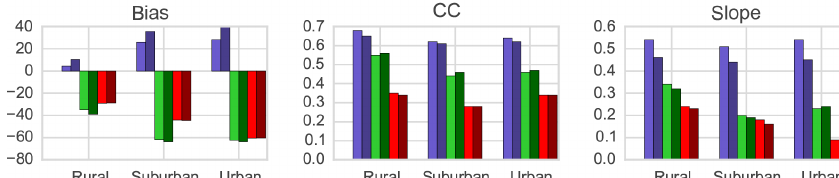
Figure 3. Averaged biases (%), correlation coefficients (CC) and slopes of model and station daily values for rural, suburban and urban stations. The specific gases are indicated by colors: Ozone – blue, NO 2 – green, SO 2 – red; lighter colors mean the CBMZ chemical mechanism, darker